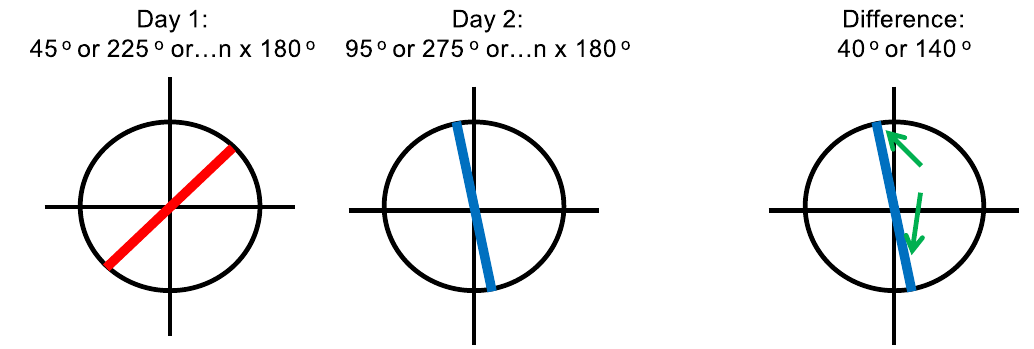
Figure 3. Schematic view of the variability of the Polarization Angle and how the 180 o multiplicity affects it. To choose the rotation sense, we always kept the difference between them lower than 90 o